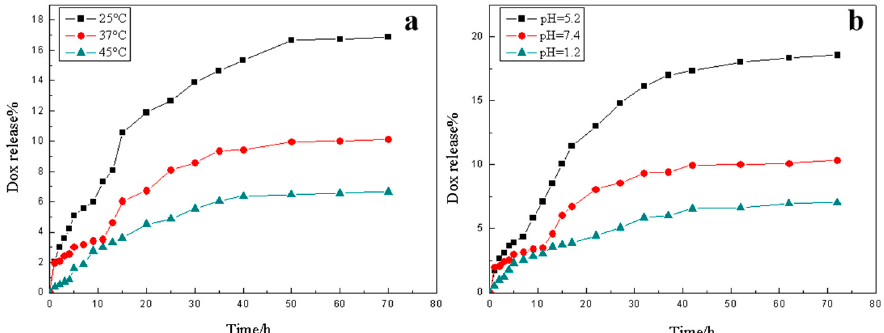
Figure 8. Drug release curve of the dox-loaded hydrogel in phosphate buffered saline solution (PBS) with ( a ) pH = 7.4 at a different temperature, ( b ) 25 °C at a different pH .